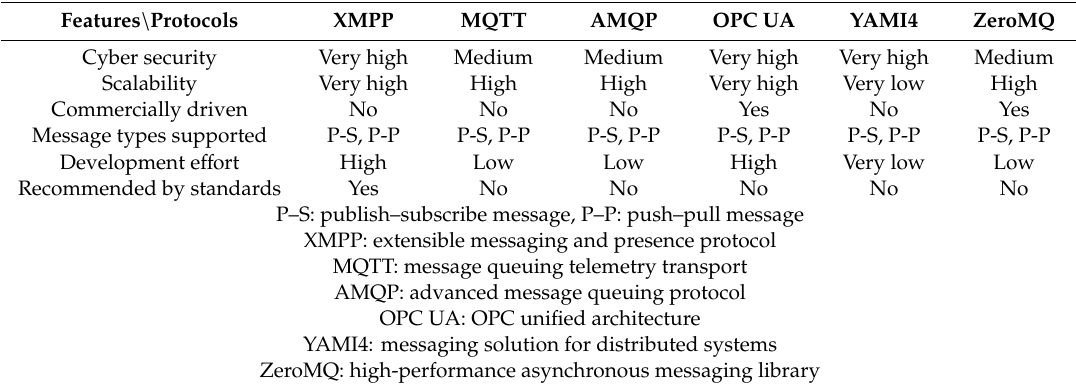
Table 2. Comparison of di ff erent middleware solution